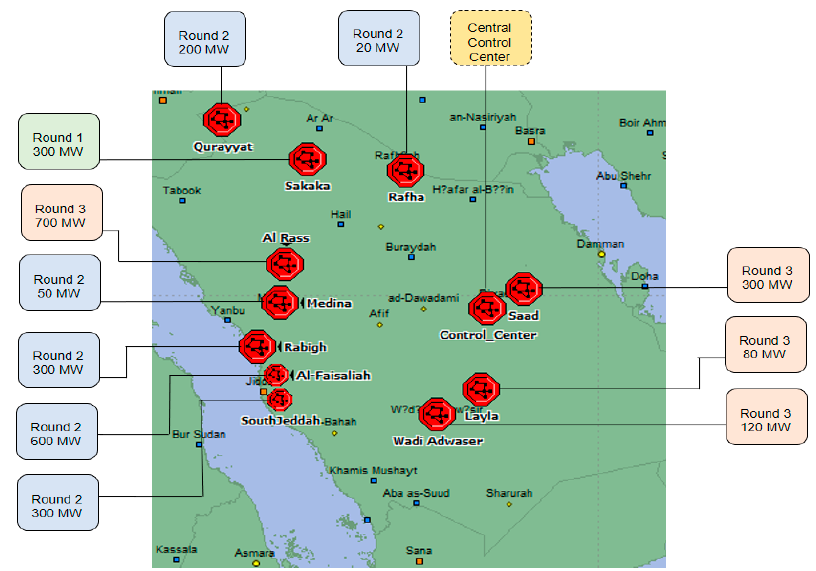
Figure 7. Geographical location of future PV power projects across Saudi Arabia.